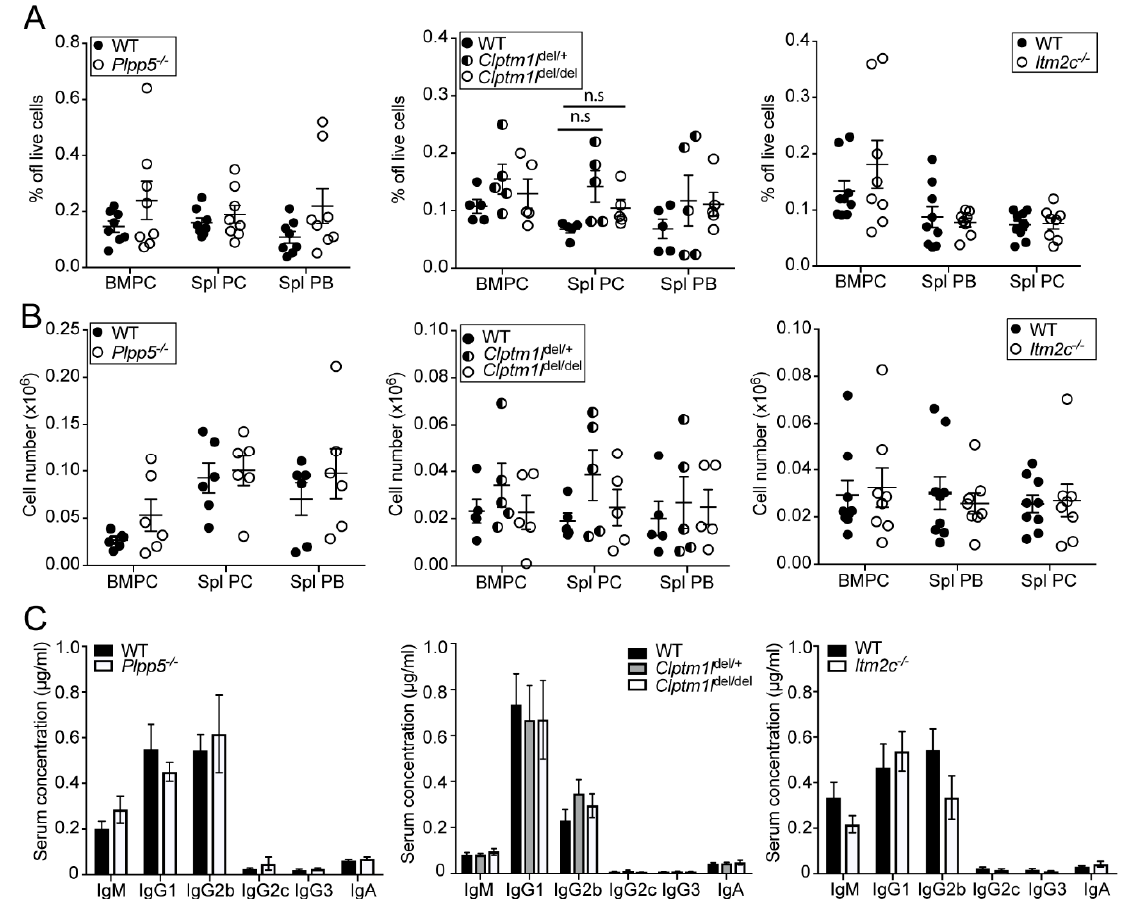
Figure 6. Characterization of ASC populations in Plpp5 − / − , Clptm1l del/+ , Clptm1l del/del and Itm2c − / − mice. ( A ) Frequency and; ( B ) total cell number of bone marrow plasma cells (BMPC), splenic plasma cells (Spl PC) and splenic plasmablasts (Spl PB) in Plpp5 − / − , Clptm1l del/+ , Clptm1l del/del , Itm2c − / − and age-matched WT mice. Results are combined from two ( Clptm1l ) or three ( Plpp5 , Itm2c ) independent experiments. Each dot represents a single mouse, horizontal lines show the means ± SEM; ( C ) serum concentration of immunoglobulin isotypes in Plpp5 − / − , Clptm1l del/+ , Clptm1l del/del , Itm2c − / − and age- and sex-matched WT mice as determined by ELISA. Data are the mean of six samples from two independent experiments ± SEM. Statistical significance was analyzed using unpaired t -test, correcting for multiple comparisons. n.s., not significant ( p > 0.05).